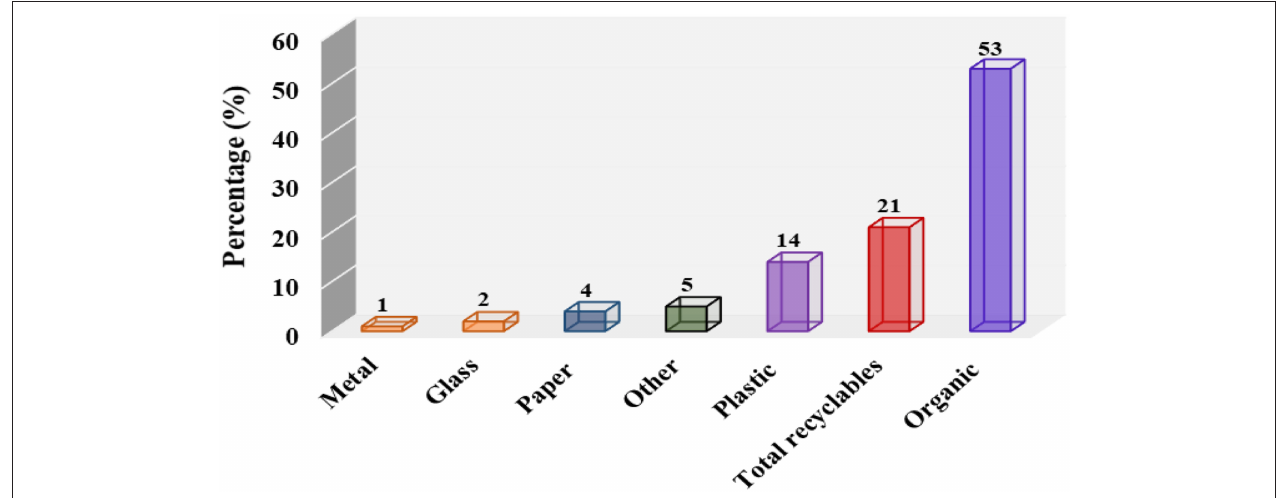
FIGURE 8 | Composition of municipal waste (Zuberi and Ali, 2015).